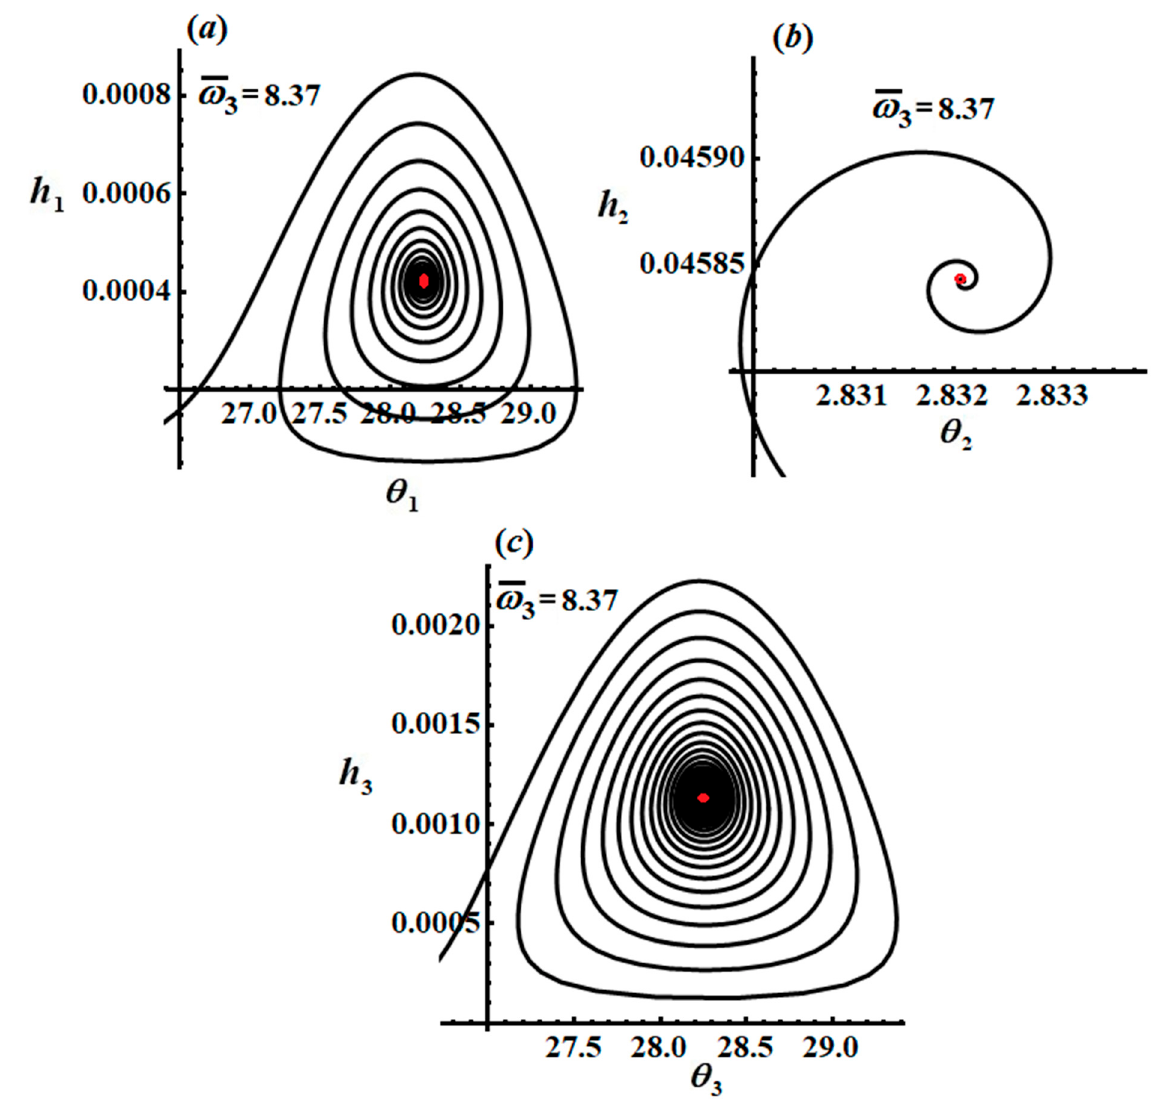
Figure 10. The amplitude modulation of h